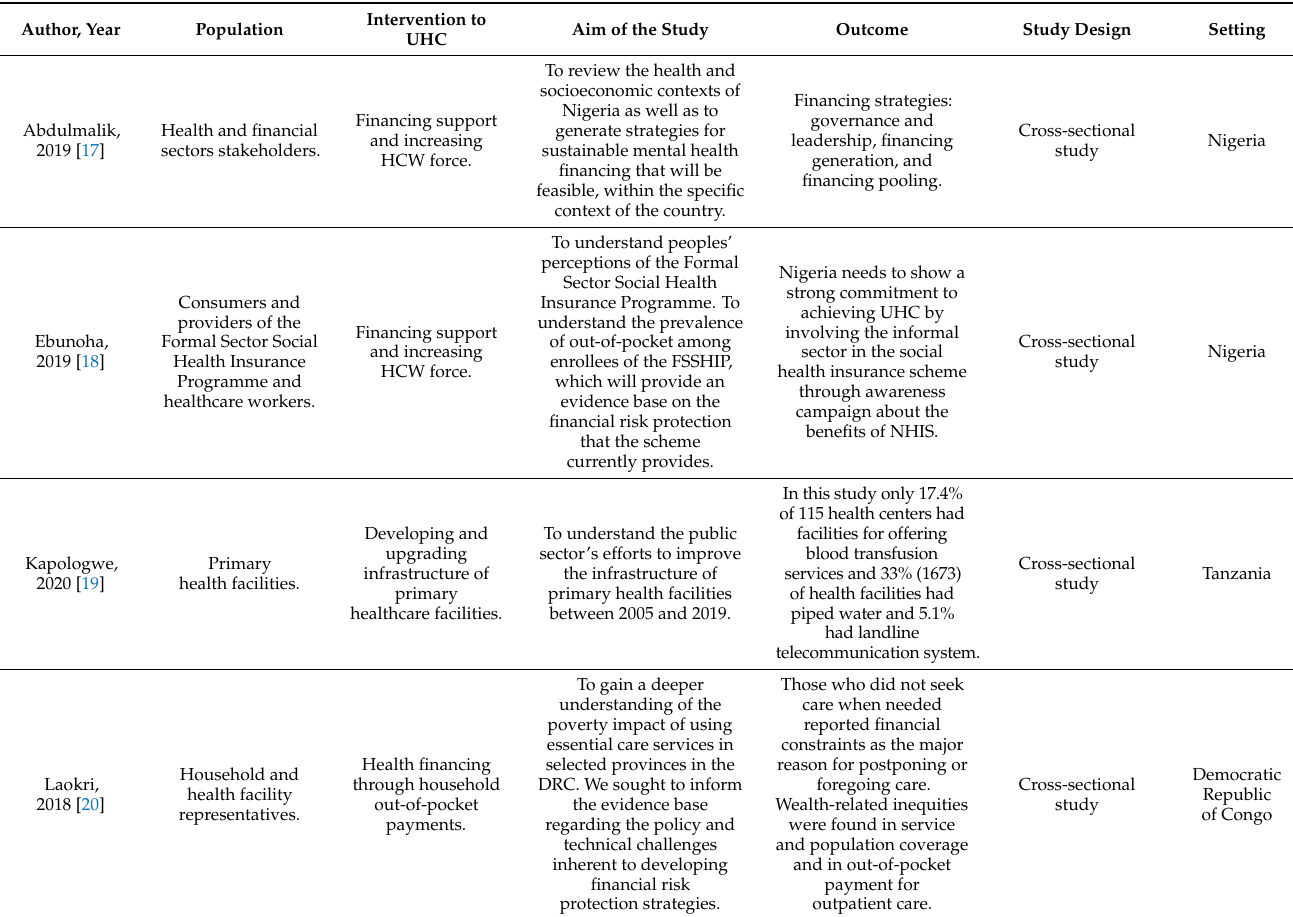
Table 3. Characteristics of included